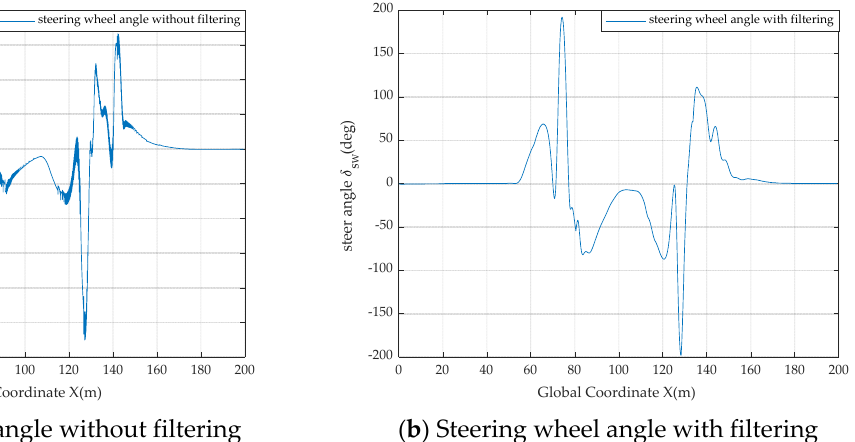
Figure 6. The steering wheel angle with and without filtering at RAC = 0.9 and VS = 20 m/s.